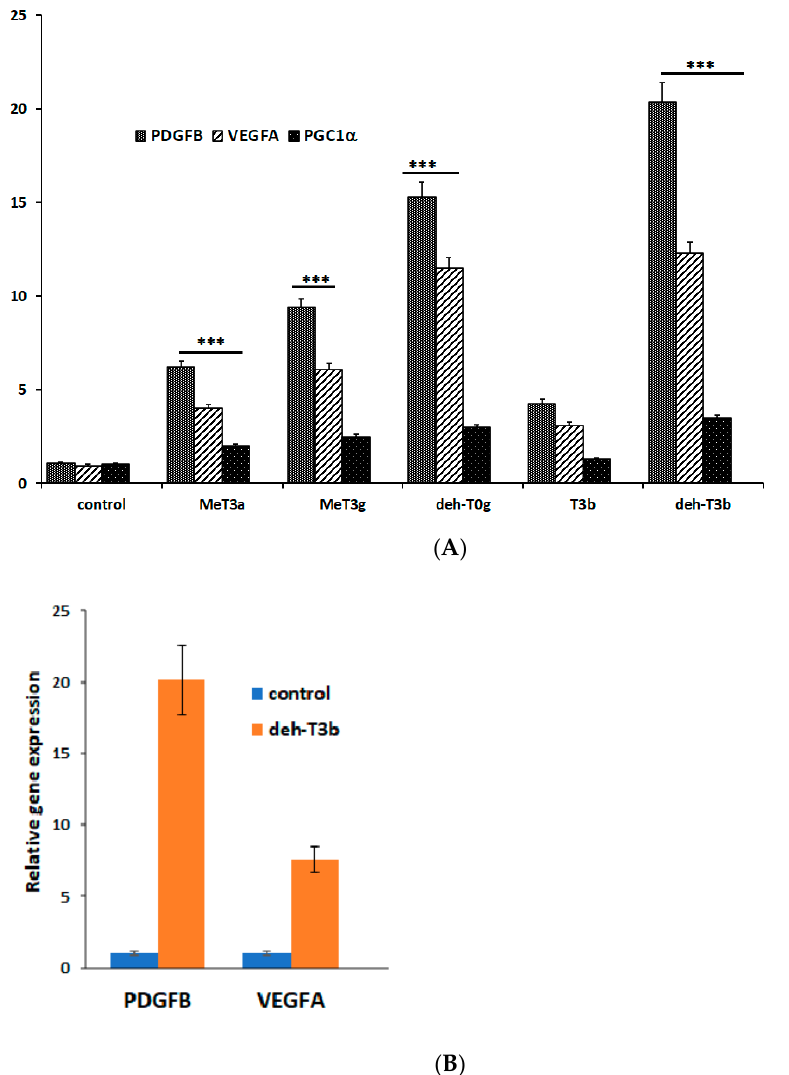
Figure 2. ( A ) Overnight serum-starved human dermal fibroblast (HDF) cells were cultured in the presence of 10 µ M of each of the modified tocotrienol products for 3 h. Total RNA was isolated and gene expression was analyzed by qPCR (ABI 7300, Applied Biosystems). The values provided are the mean ± SD (n = 5). Control, HDF cells incubated in the presence of vehicle (ethanol); MeT3 α , mono-epoxy-tocotrienol- α (naturally occurring tocotrienol- α with one epoxide on its side chain described in [8]); deh-T0 γ , dehydro-tocotrienol- γ (naturally occurring tocotrienol- γ with truncated side-chain); T3 β , tocotrienol- β (naturally occurring tocotrienol- β ); deh-T3 β , naturally occurring tocotrienol- β with a double bond on the chromanol ring as described in Figure 1. All these products upregulate the expression of growth factors PDGFB and VEGFA as well as PGC1 α . Data are normalized to the expression of HMBS1 in each sample and presented as the relative expression of the control group. Values are mean ± SD; *** p < 0.001. ( B ) Gene expression levels of PDGFB and VEGFA in skin from mice treated with deh-T3 β